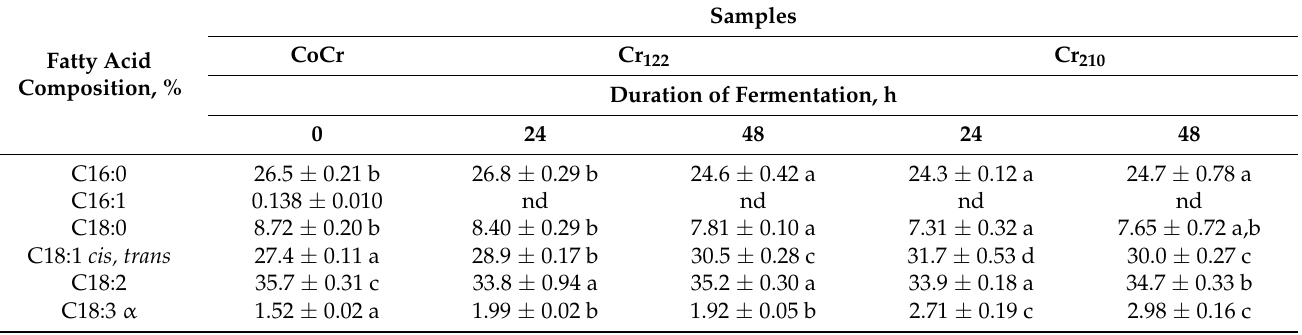
Table 3. Fatty acid (FA) composition (percentage of total fat content) in cricket flour